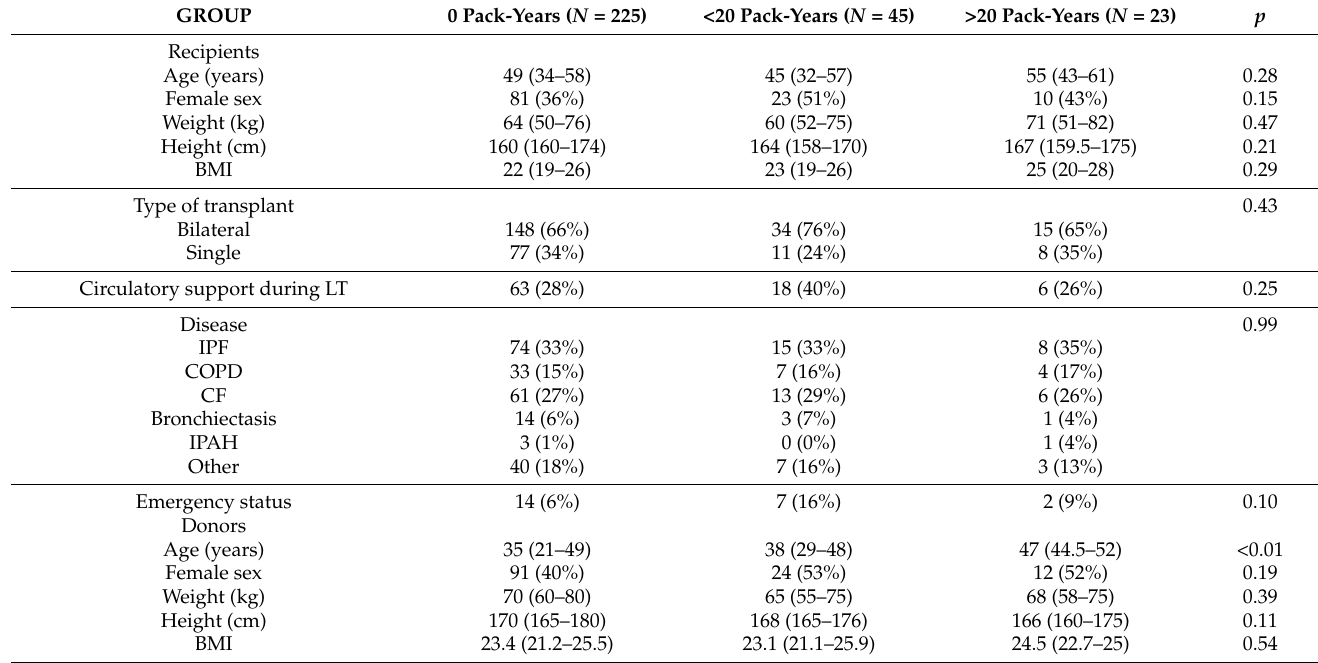
Table 1. Baseline recipient and donor characteristics 1